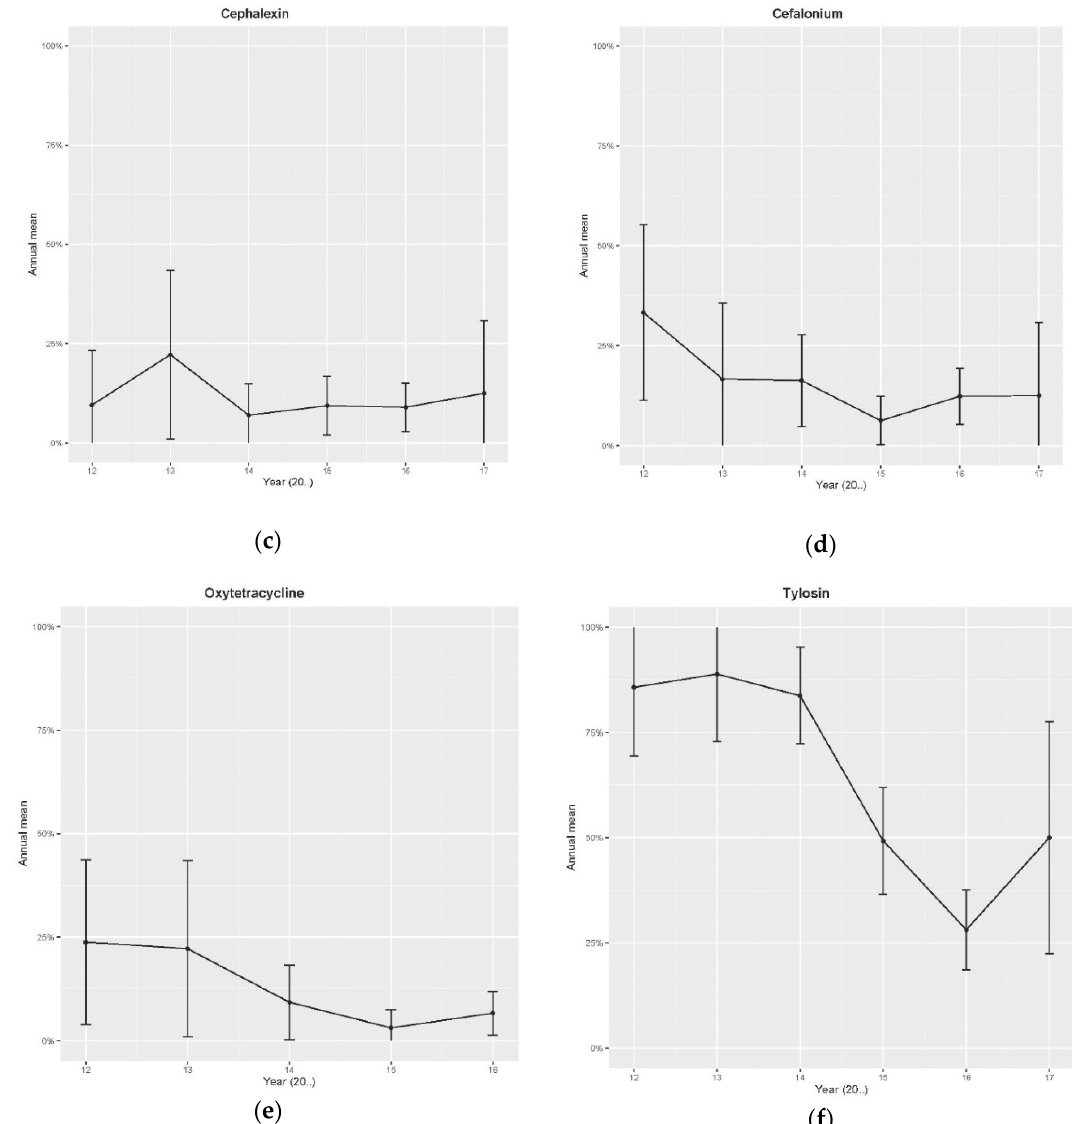
Figure 1. Trends of antibiotic resistance mean (proportion of isolates per year) of maltose-negative S. aureus (disk diffusion, retrospective data), according to CLSI [13,14]: ( a ) to ampicillin, ( b ) to penicillin G, ( c ) to cephalexin, ( d ) to cephalonium, ( e ) to oxytetracycline and ( f ) to tylosin.